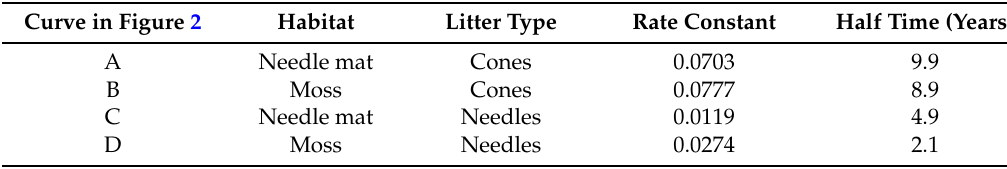
Table 2. Decomposition Rates and Half Times for Cones and Needles in Moss Vegetation and in Vegetation-Free Needle Mats.